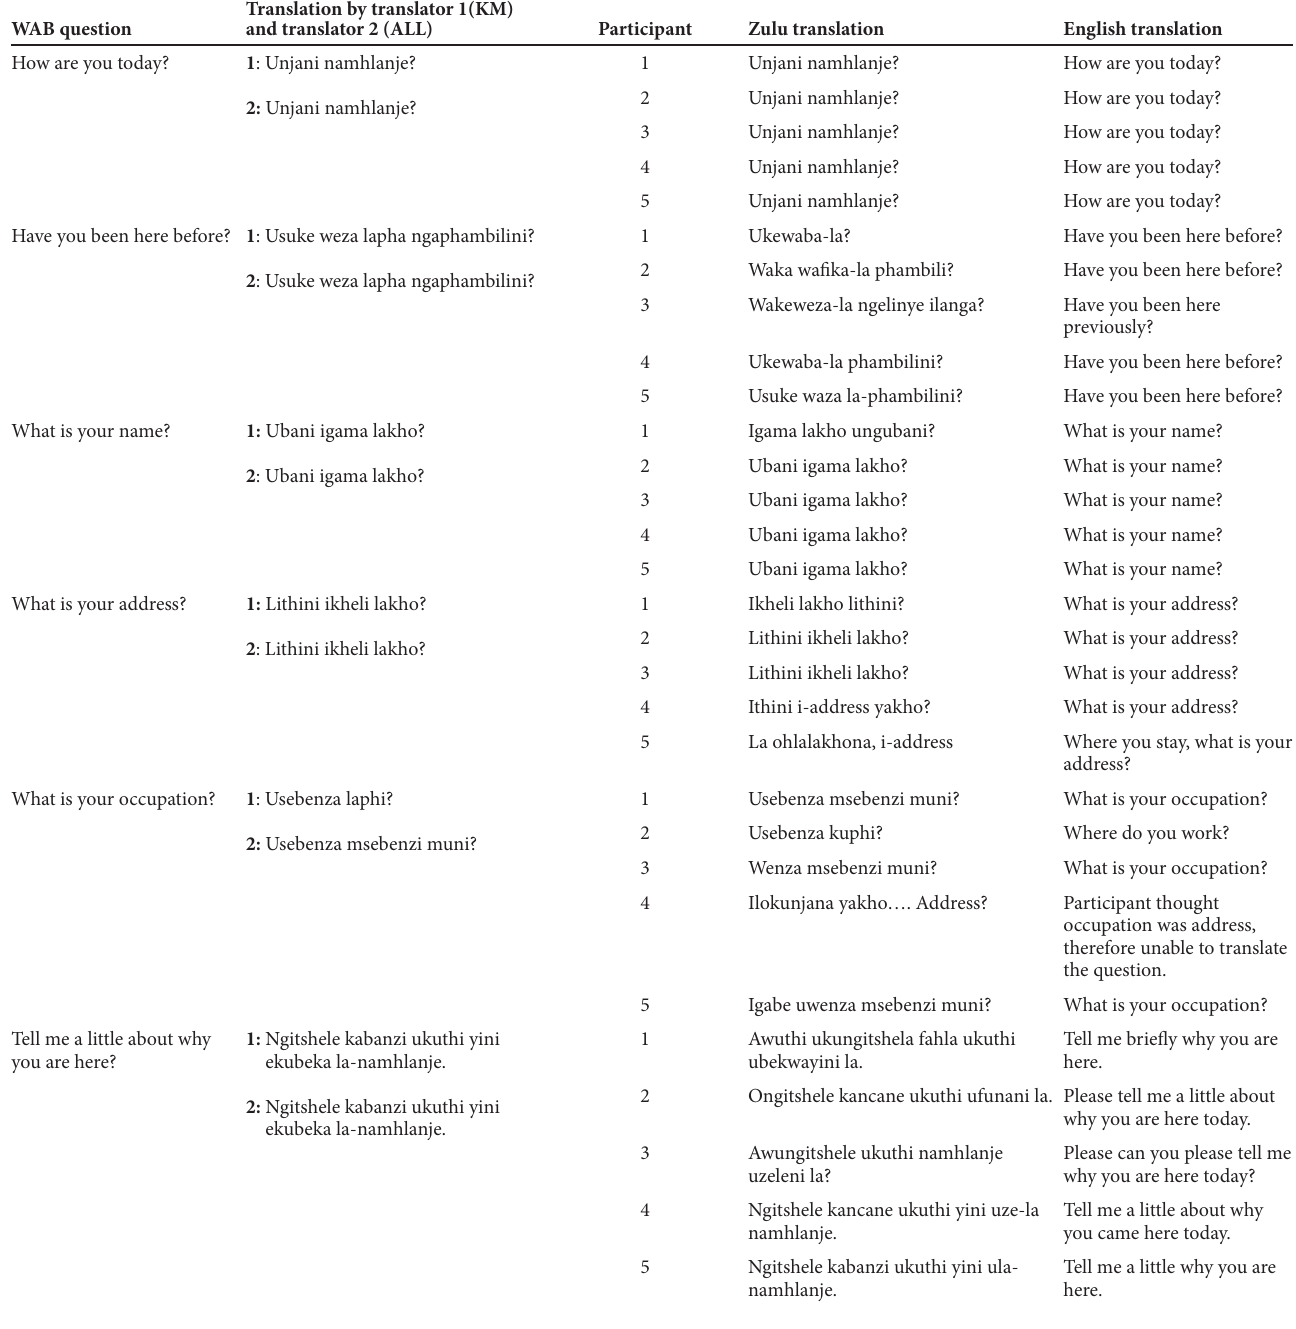
Table 3. Translation of the spontaneous speech subtest of the WAB WAB